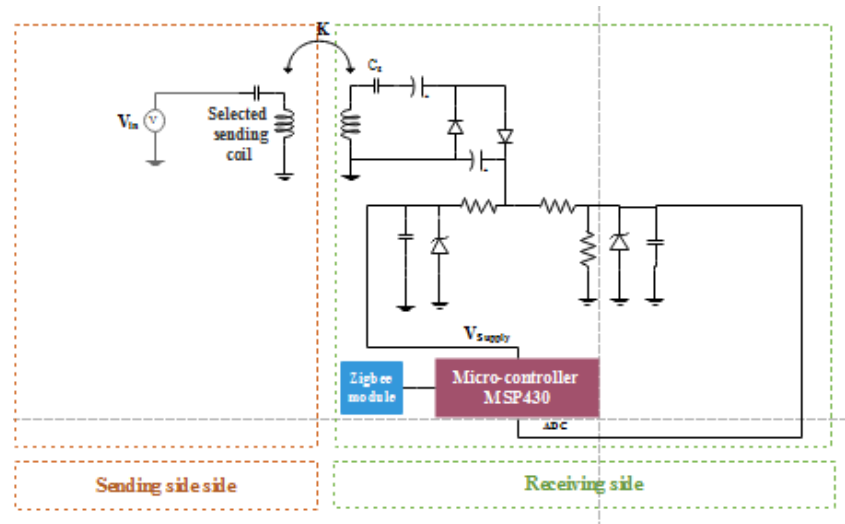
Figure 11. Receiving side circuit architecture.